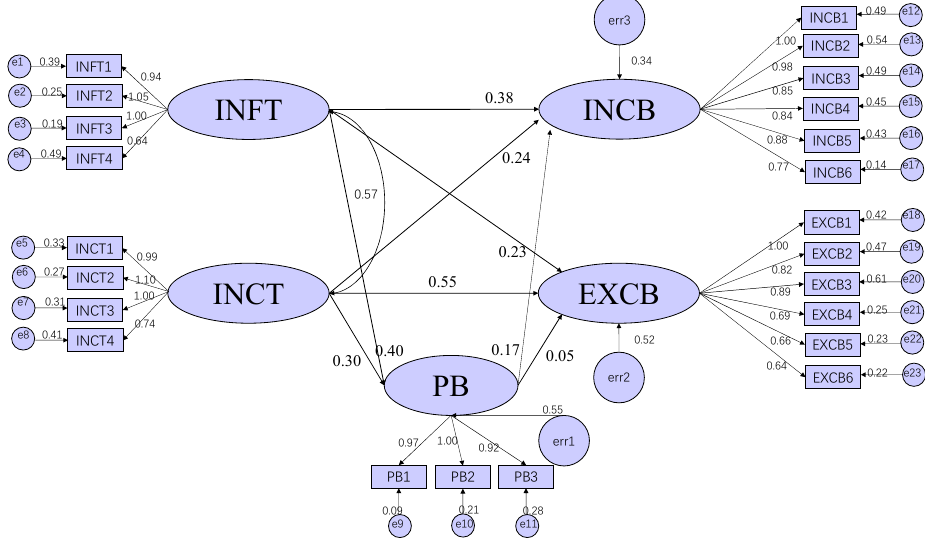
Figure A2. Unstandardized estimate of the SEM model.